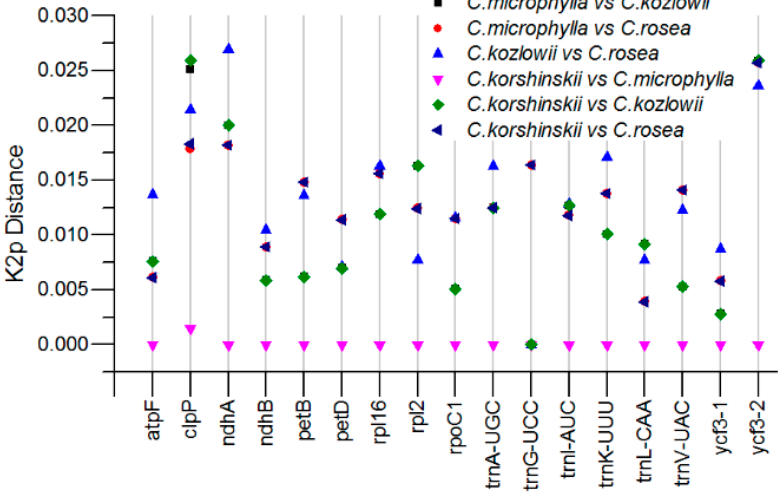
Figure 4. K2p distances for introns among C. rosea , C. microphylla , C. kozlowii , and C. korshinskii .